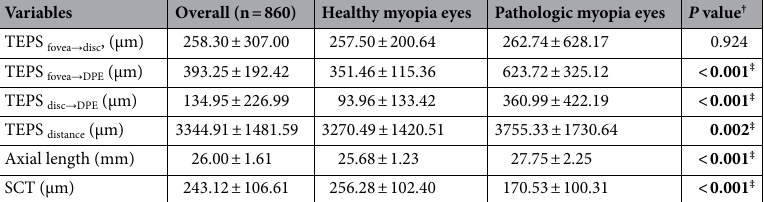
Table 2. Six ocular instrumentation input in five classification model*. SCT subfoveal choroidal thickness; TEPS tomographic elevation of the posterior sclera. *Data are presented as mean ± standard deviation unless otherwise indicated. † Independent t -test for continuous variables. ‡ Statistically significant values ( P < 0.05) are shown in